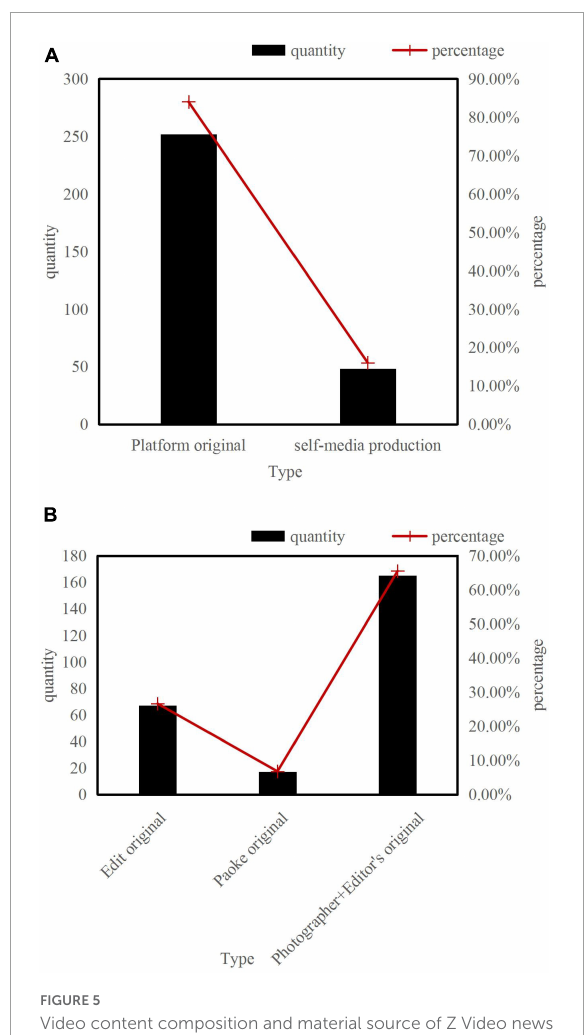
FIGURE5 Video content composition and material source of Z Video news information. (A) Composition of Z Video news and information video content. (B) Sources of Z Video news and information video content.